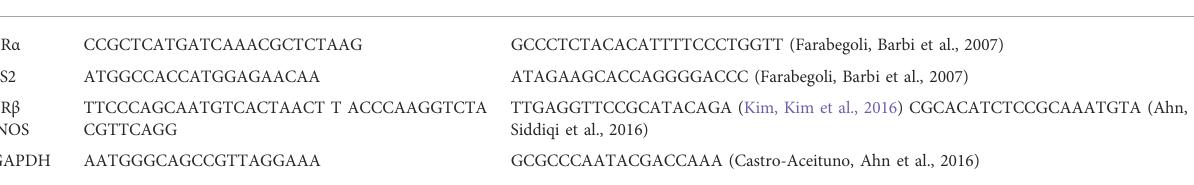
TABLE 2 The list of primers used for the RT-PCR. Genes Forward primers Reverse primers ER α pS2